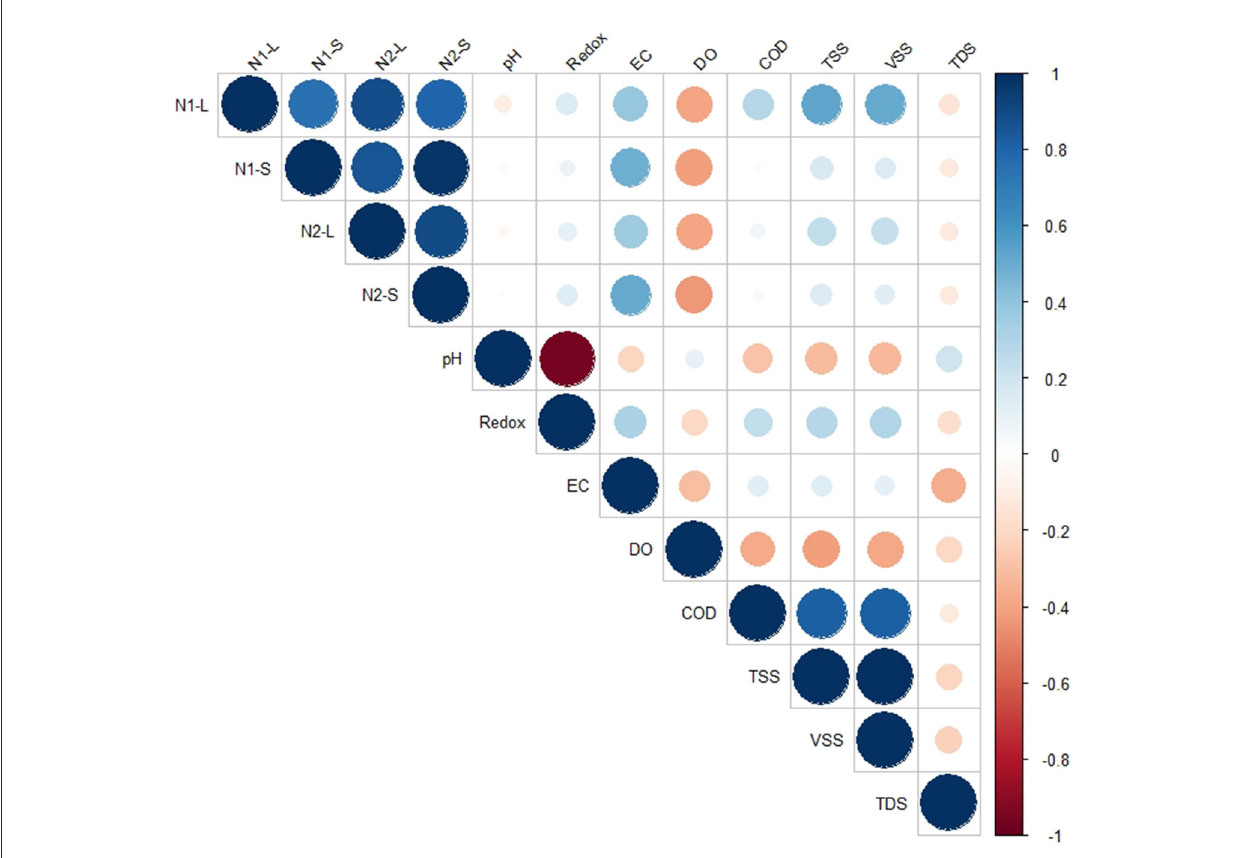
FIGURE3 Correlation between SARS-CoV-2 biomarker concentrations in the liquid and solid phase, and physicochemical parameters measured across coastal New England